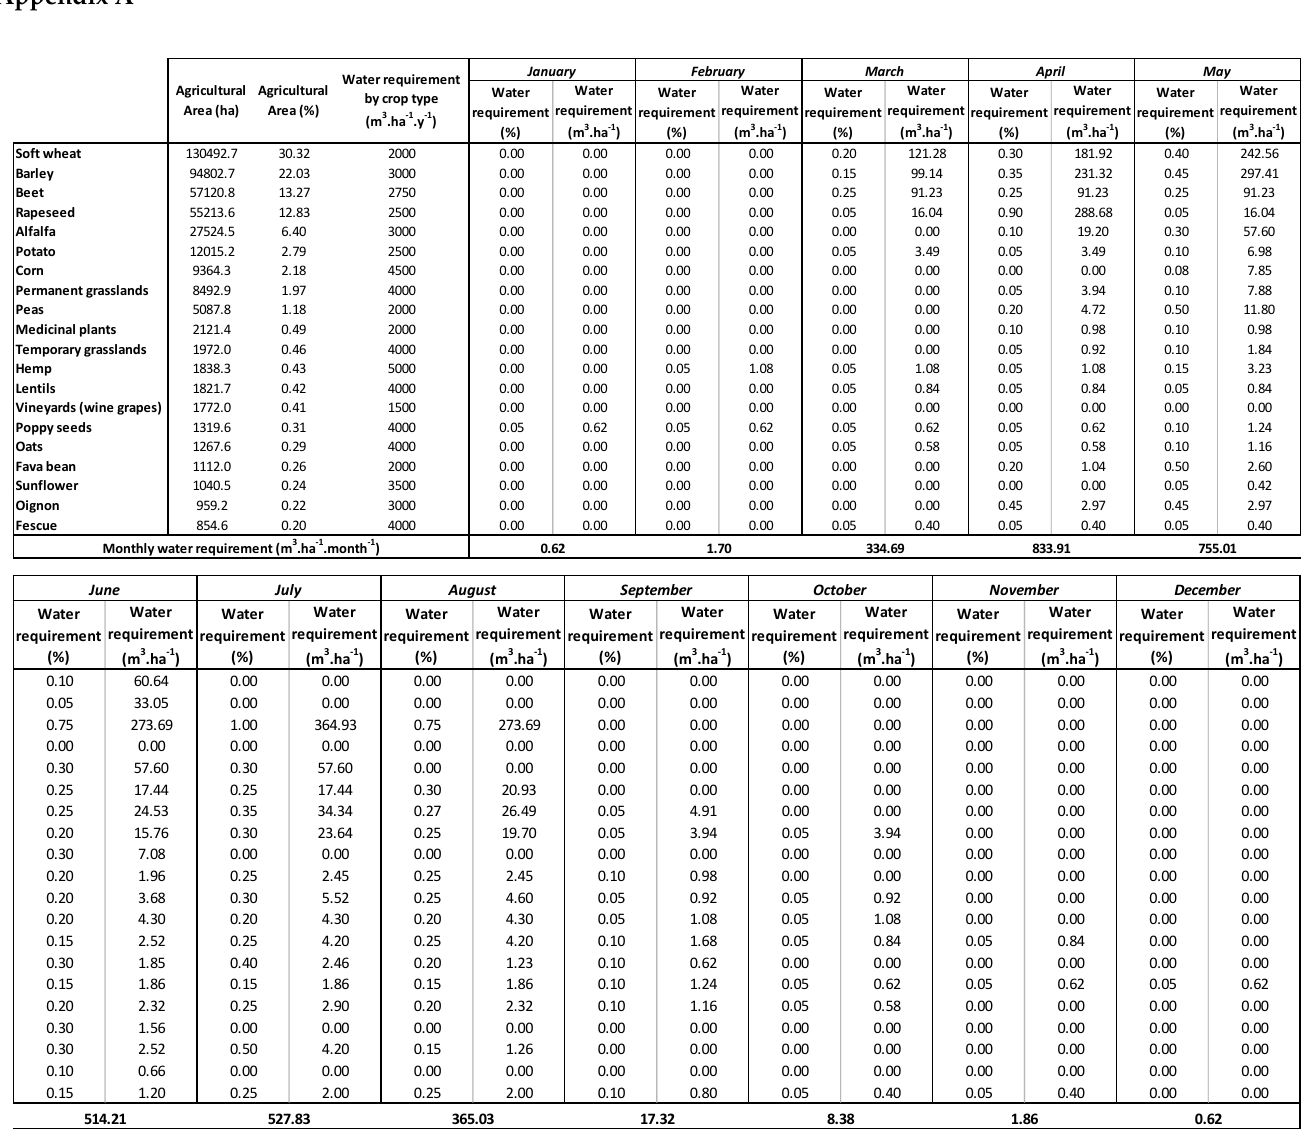
Figure A1. Details of the construction and of the values of the irrigation inputs for the different types of crops as a function of the surface, the water requirement and the season (by months).